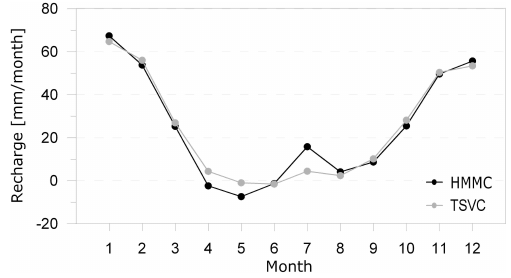
Fig. 18. Average monthly simulated groundwater recharge for all grids in the National model for the two optimised